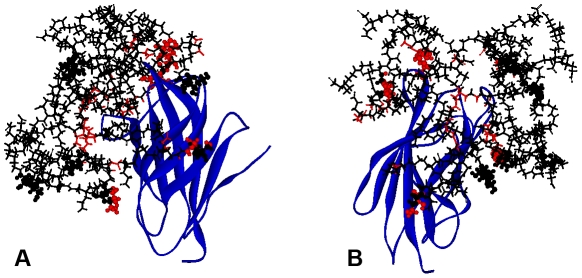
Interaction of the partially glycosylated dendrimer's surface with human MD-2's surface.Residues shown in red are <1.3 Å away from the surface of human MD-2. Glucosamine residues are shown in ball and stick configuration. (A) Side view of human MD-2's pocket; (B) frontal view of human MD-2's pocket.